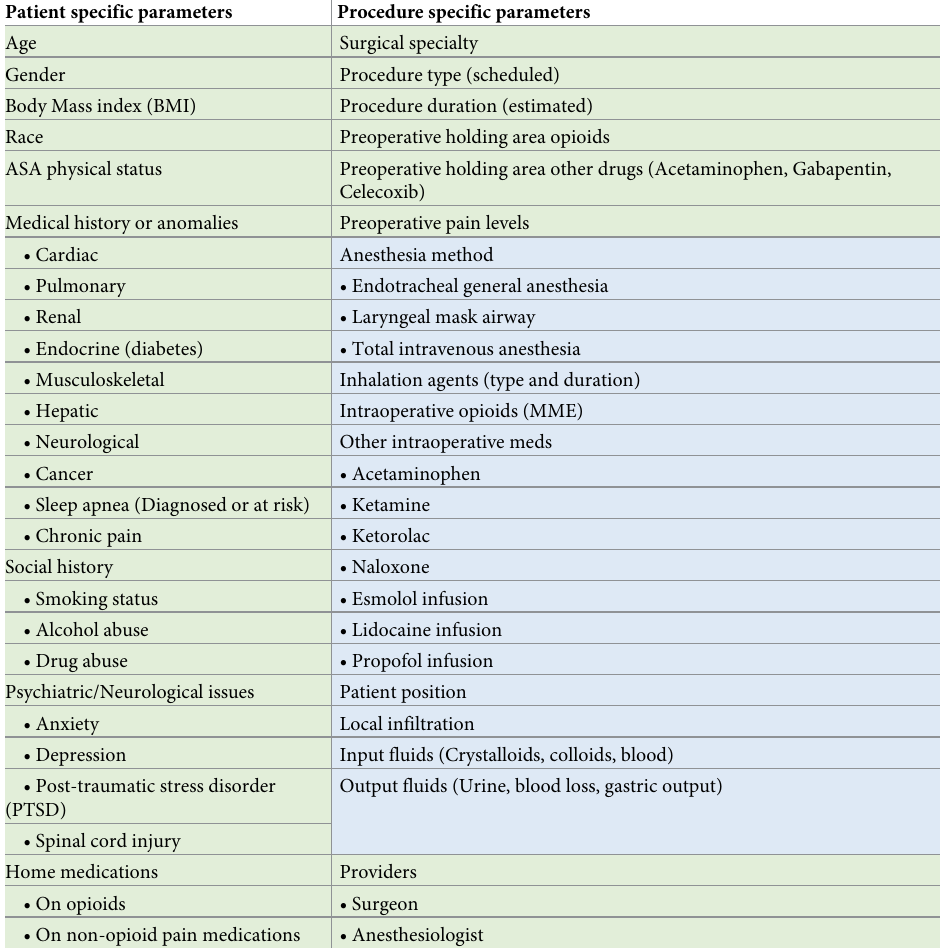
Table 1. Parameters used in prediction models. The parameters marked in green were used for postoperative opioid requirements prediction prior to surgery and parameters marked in blue were added to the prediction models to per- form a postoperative opioid requirements prediction at the end of